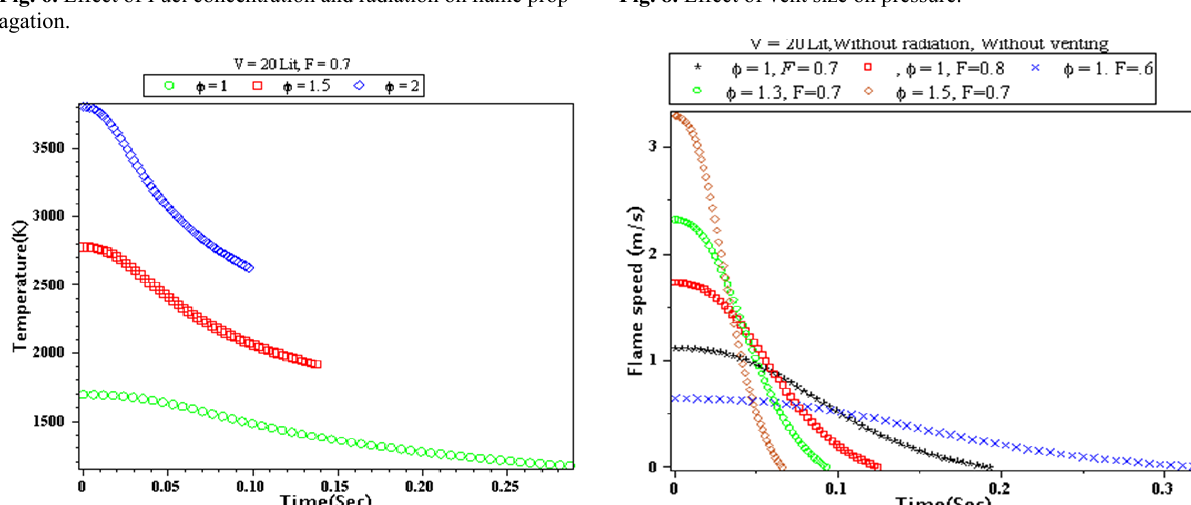
Fig. 8. Effect of vent size on pressure.